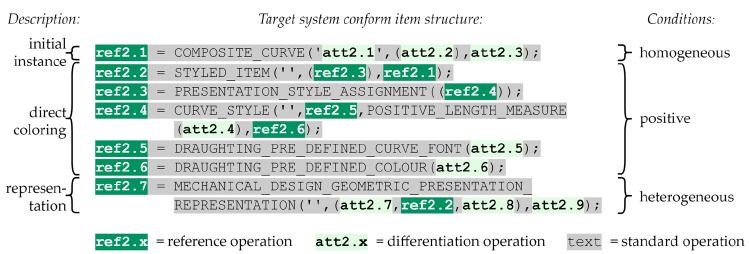
Figure 9. Target system (Catia) conforms to the item structure of the sketch coloring.